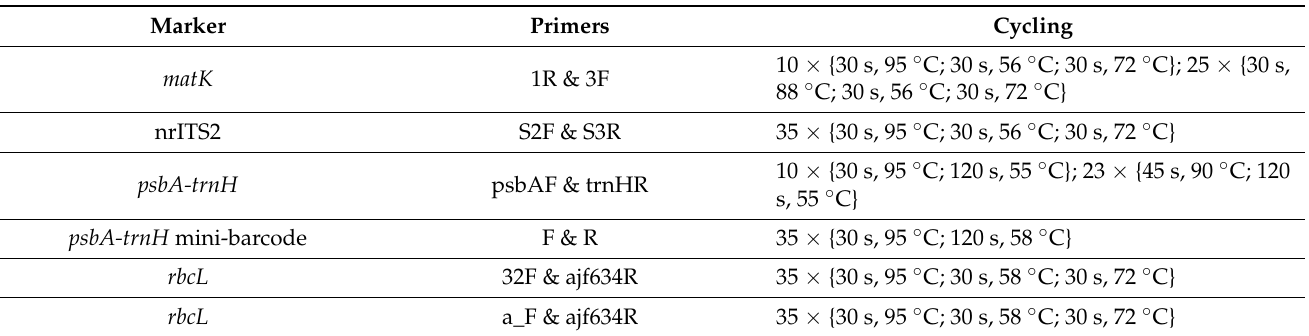
Table 4. PCR cycling conditions used. Amplification reactions used an initial denaturation of 150 s at 95 ◦ C and a